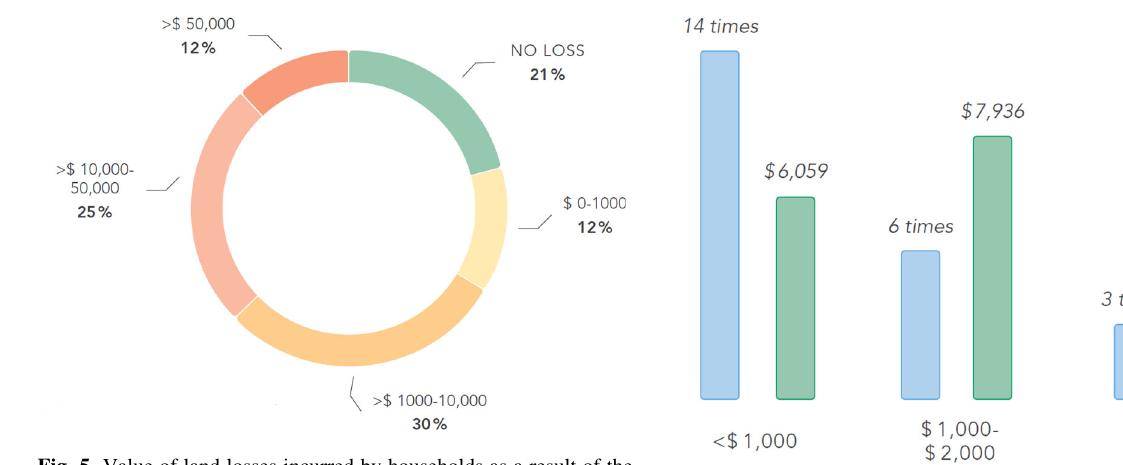
Fig. 5 Value of land losses incurred by households as a result of the 2 August 2014 Jure landslide in Sindhupalchok District, Nepal